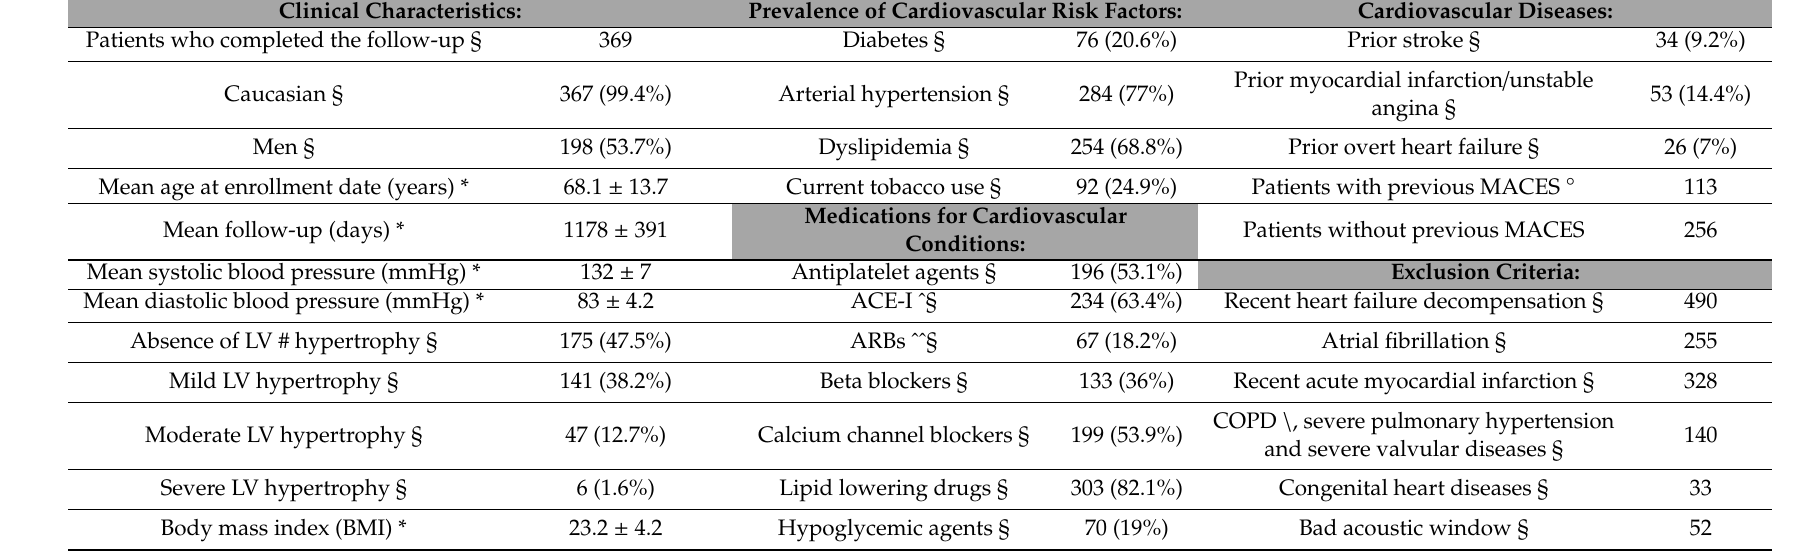
Table 1. Clinical characteristics of the enrolled